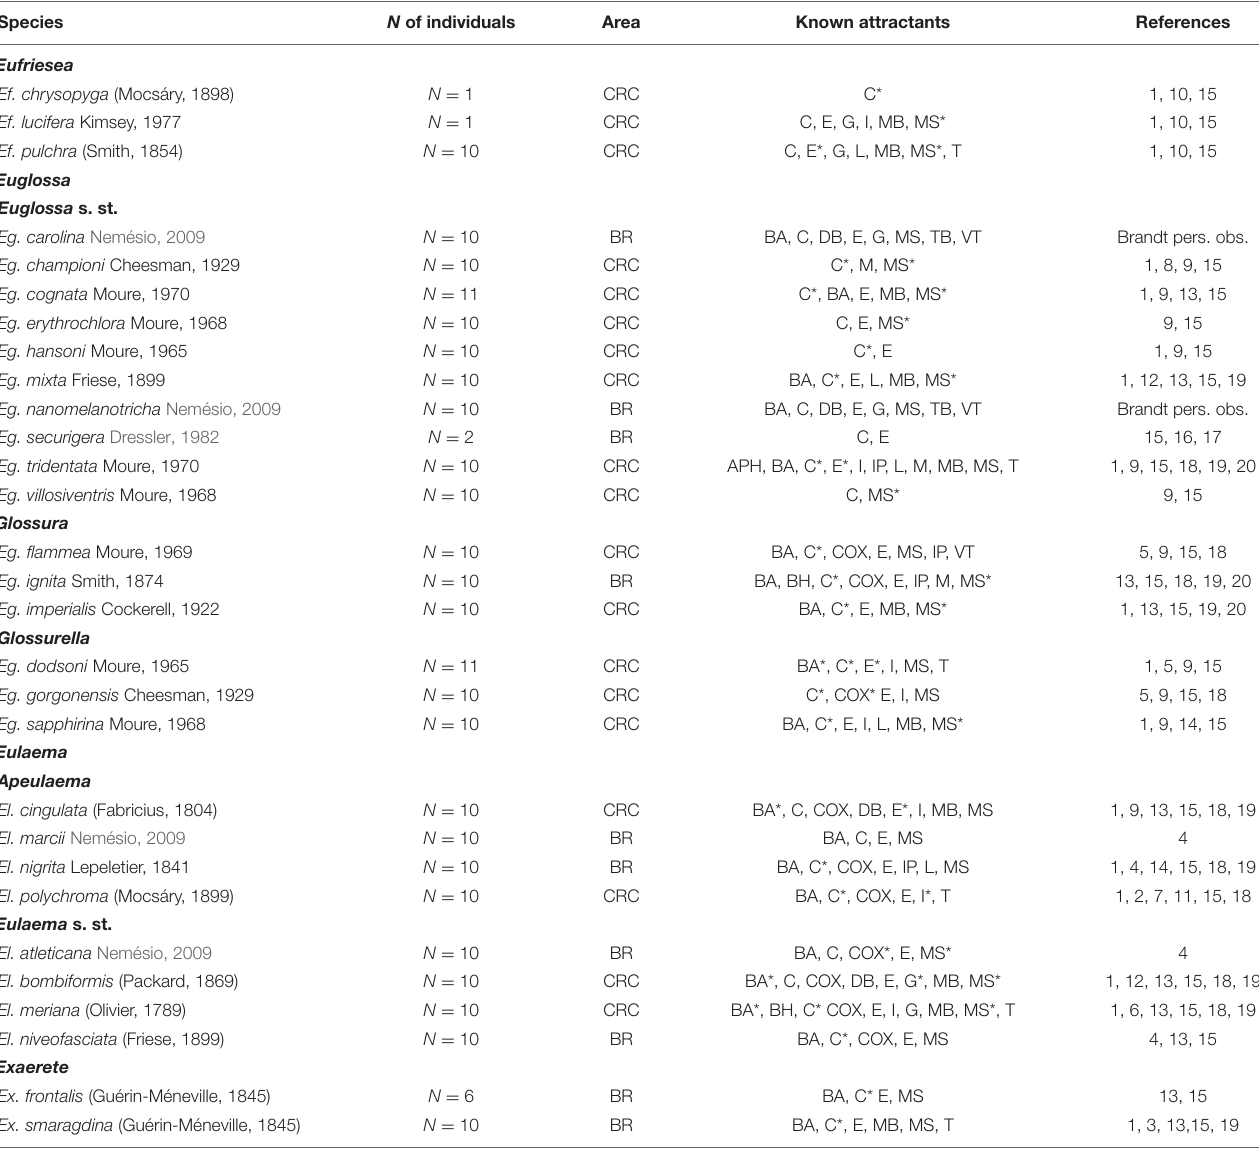
TABLE 1 | Tested euglossine species of Brazil (BR) and Costa Rica (CRC) belonging to the genera Eufriesea , Euglossa (subgenera: Euglossa s. st., Glossura , and Glossurella ), Eulaema (subgenera: Apeulaema and Eulaema s. st.), and Exaerete and known chemical compounds used in this study attracting male bees of these